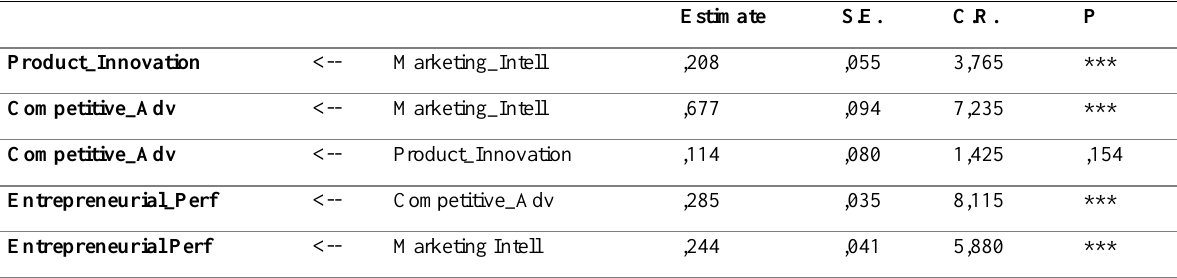
Table 8: Evaluation of Causality Test Regression